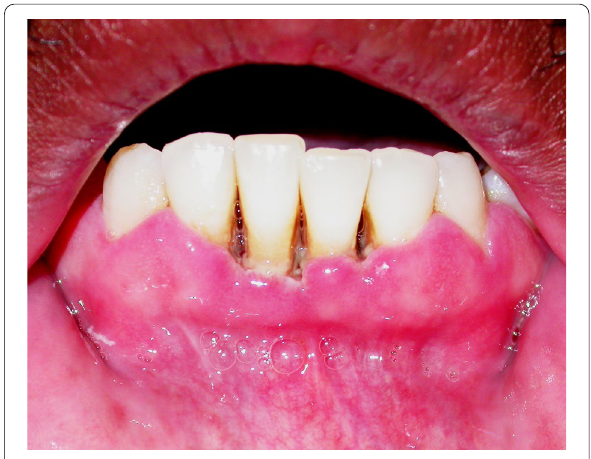
Fig. 2 Necrotising periodontitis adult seropositive subject: necrotic gingiva has separated; necrosis advancing into periodontium